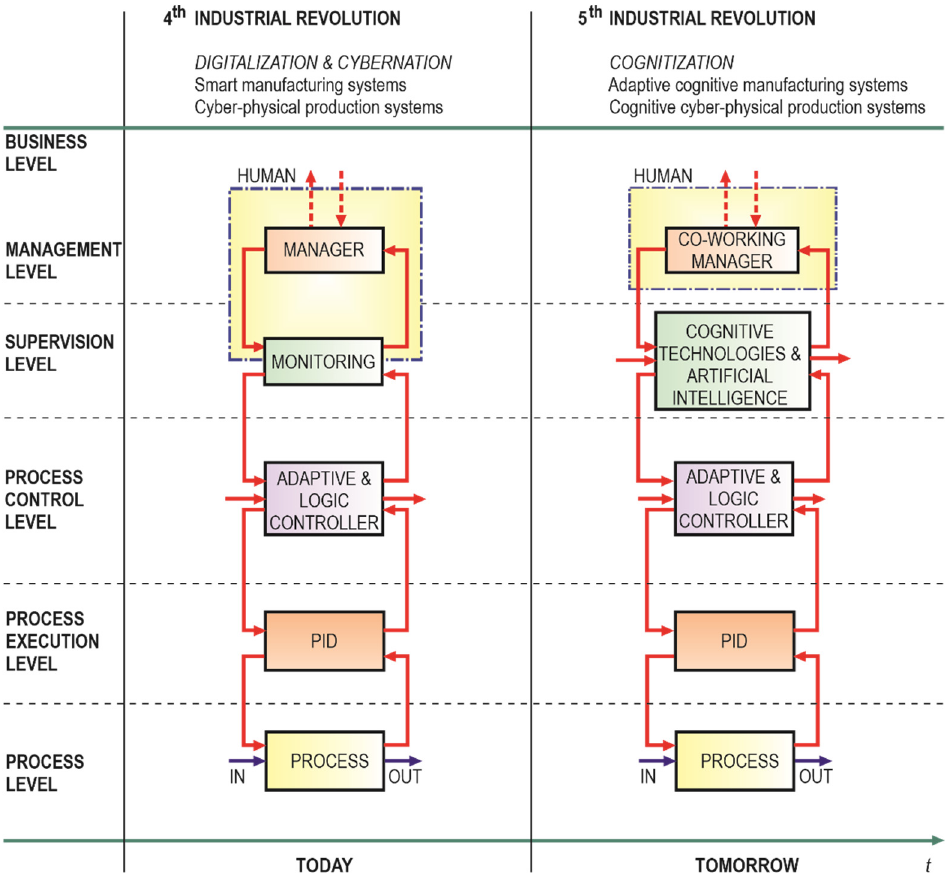
Figure 17. Transition of the human’s role from Industry 4.0 to Industry 5.0.